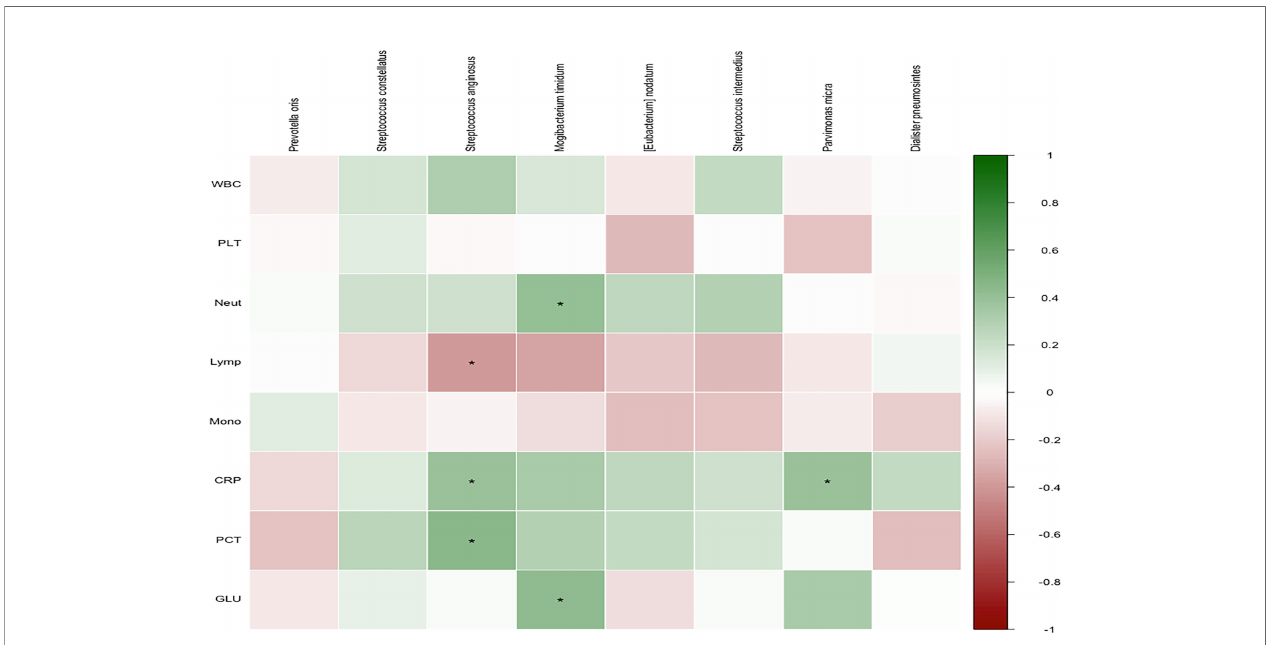
FIGURE 6 | Correlation of members of selected species with covariates. Spearman ’ s rho was calculated between selected species ’ relative abundance and phenotypic scores. Black stars within heatmap boxes indicate signi fi cant results (*p < 0.05, corr.test function in psych package of R).